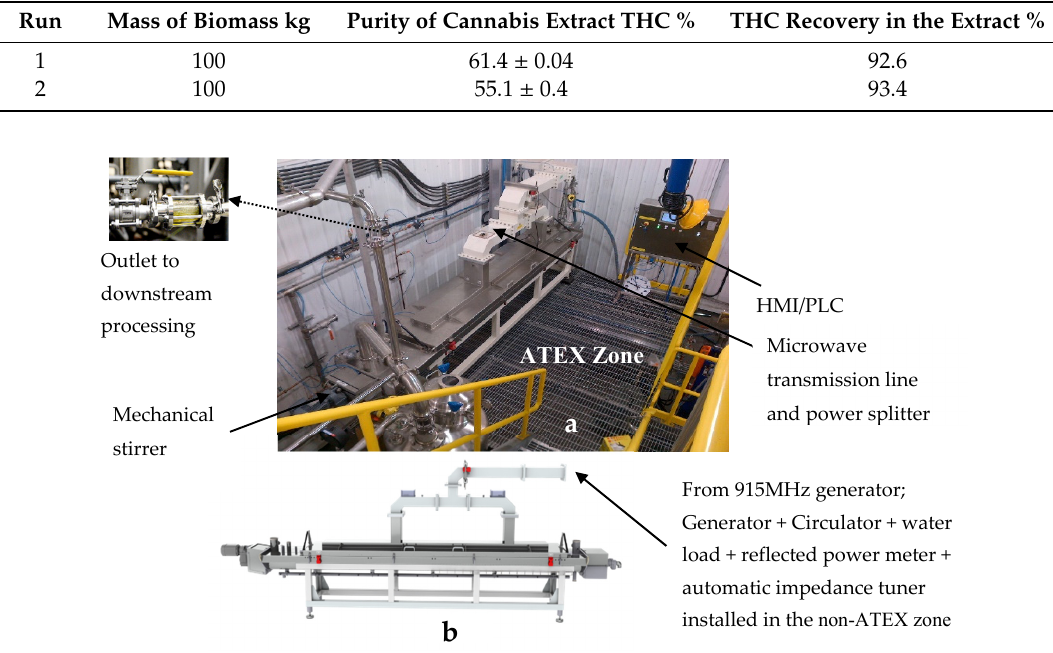
Figure 5. Photo and schematics of the MAP TM extractor in ATEX environment. ( a ) photo of the continuous flow reactor located in the ATEX production zone; ( b ) schematics of the continuous flow reactor showing the connection with the 915 MHz generator installed in a non-ATEX zone.